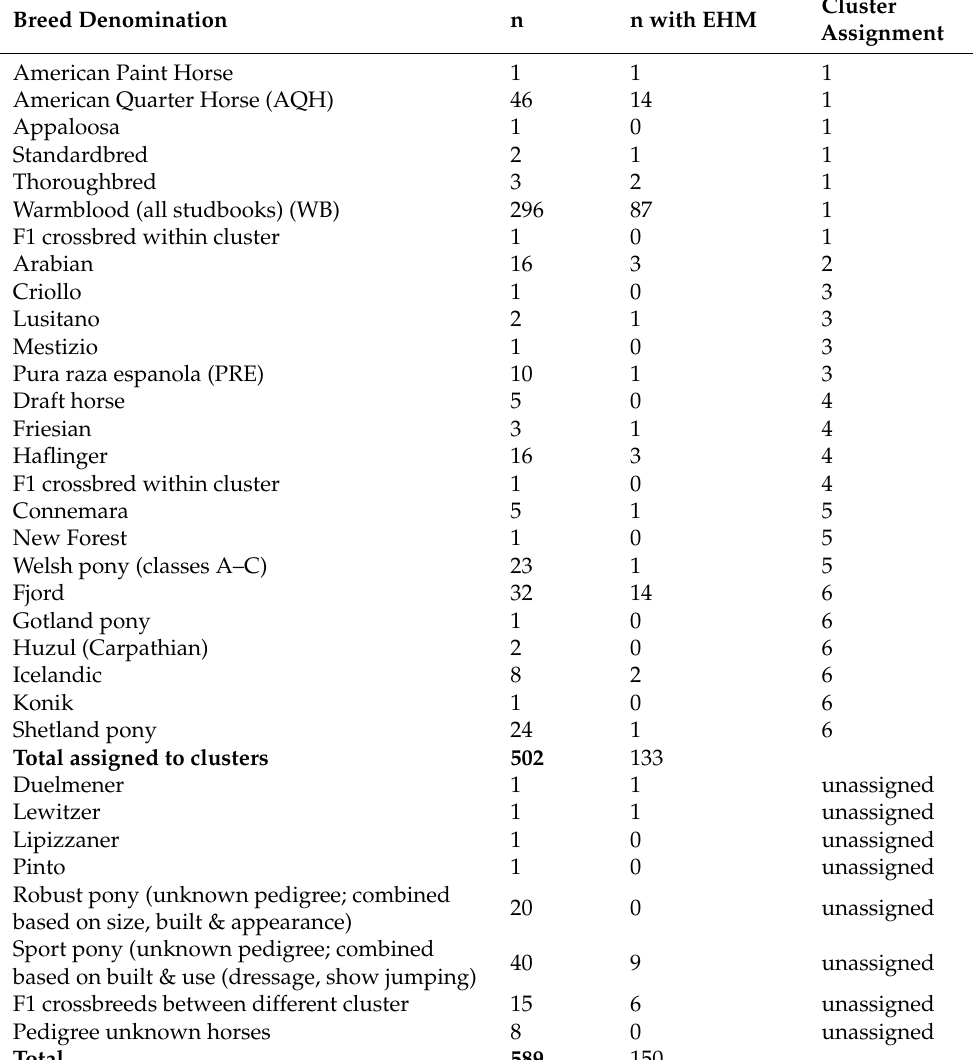
Table 1. Breeds alphabetically listed with numbers (n) of horses per breed and genetic cluster assignment (1–6).